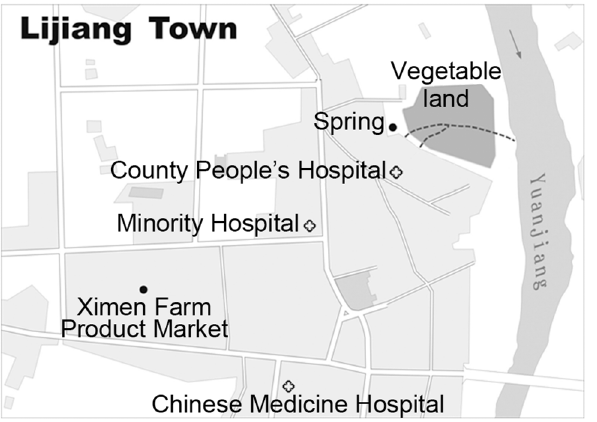
Fig 2. Map of Lijiang town of Yuanjiang county. The vegetable field used for growing raw vegetables near County People ’ s Hospital is shown as a dark-gray area. The short dashed lines indicate the wastewater from the city and hospital passing through the vegetable